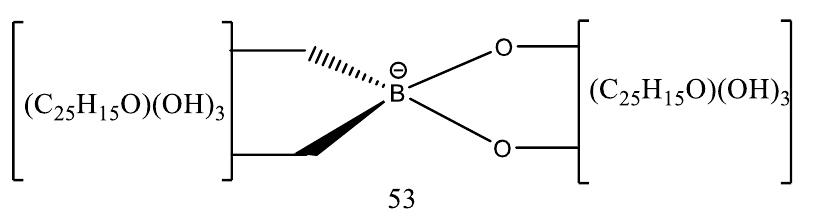
Figure 15. Structure of the main single isomeric borolithochrome (C 50 H 36 O 12 B,[M] at m / z 839).